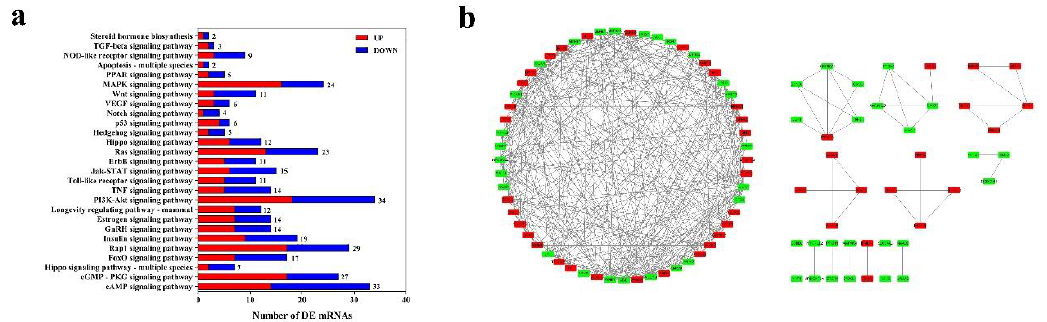
Figure 7. The crucial DE mRNAs screen. ( a ) The statistics of reproduction and growth related KEGG pathways of filtered DE mRNAs. ( b ) The network construction of 98 filtered DE mRNAs. Green and red represent the down- and up-regulated mRNAs, respectively.